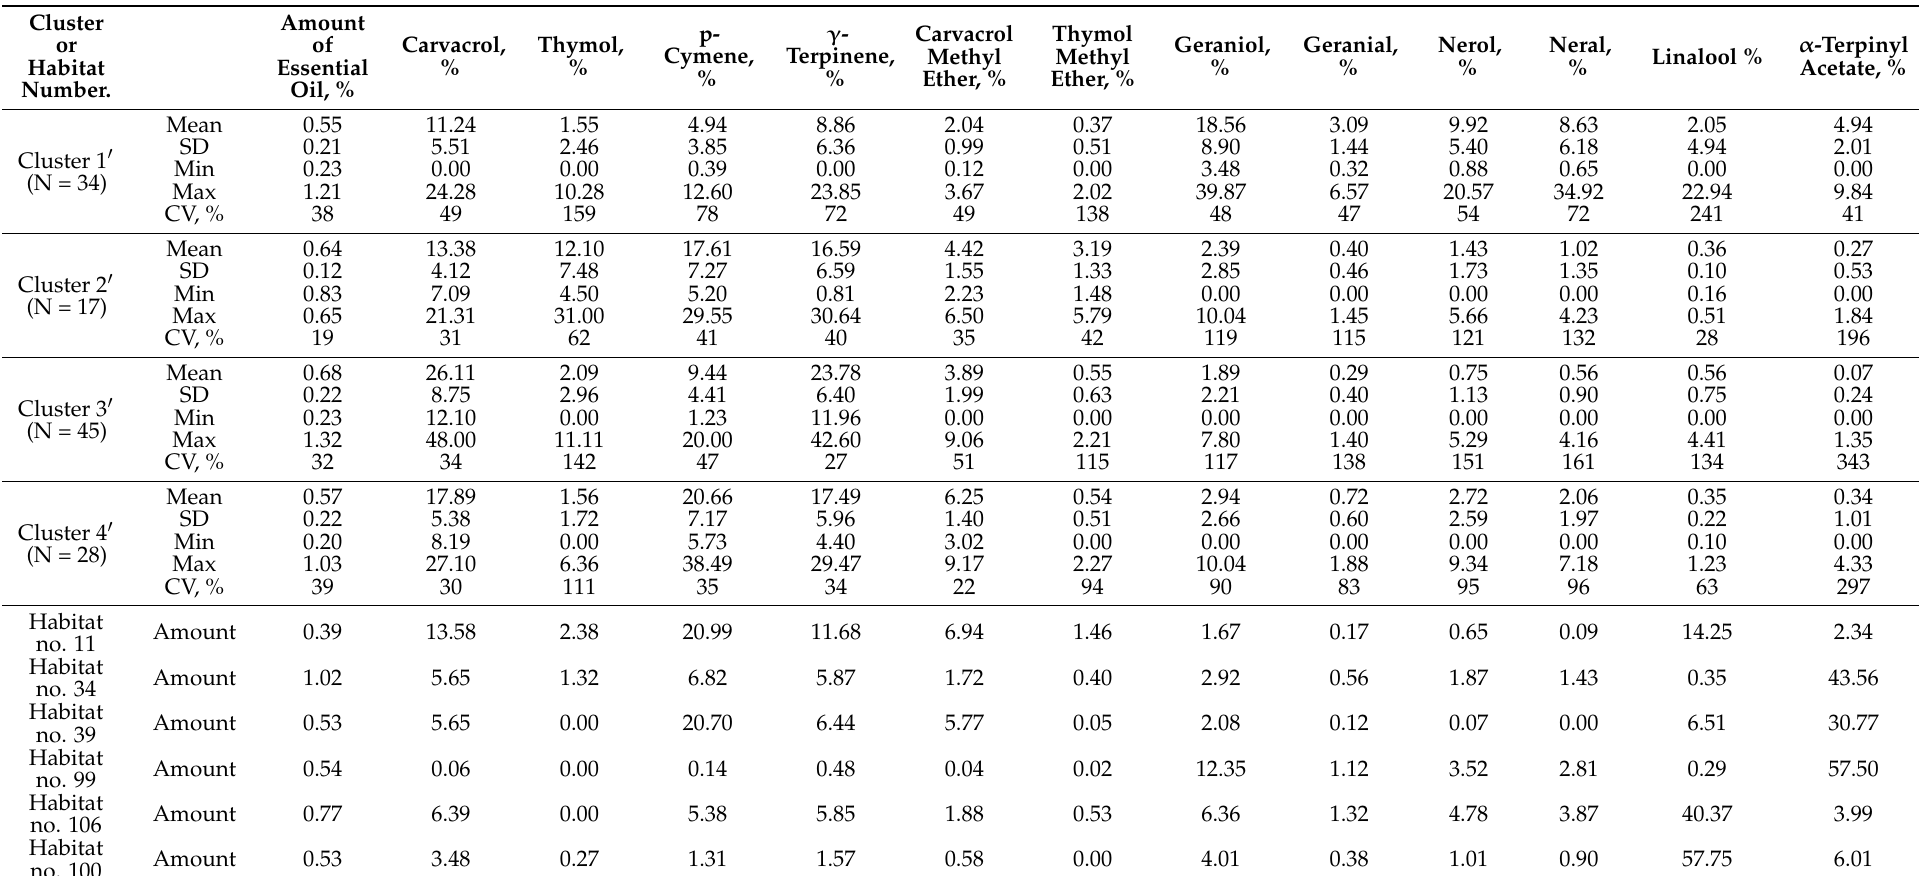
Table 2. Descriptive statistics of essential oils and percentages of main chemical compounds of chemotypes (carvacrol, thymol, geraniol, linalool, α -terpinyl acetate) and their precursors and biogenetically related compounds in distinguished clusters of Thymus pulegioides habitats and habitats no. 11, no. 34, no. 39, no. 99, no. 100 and no.